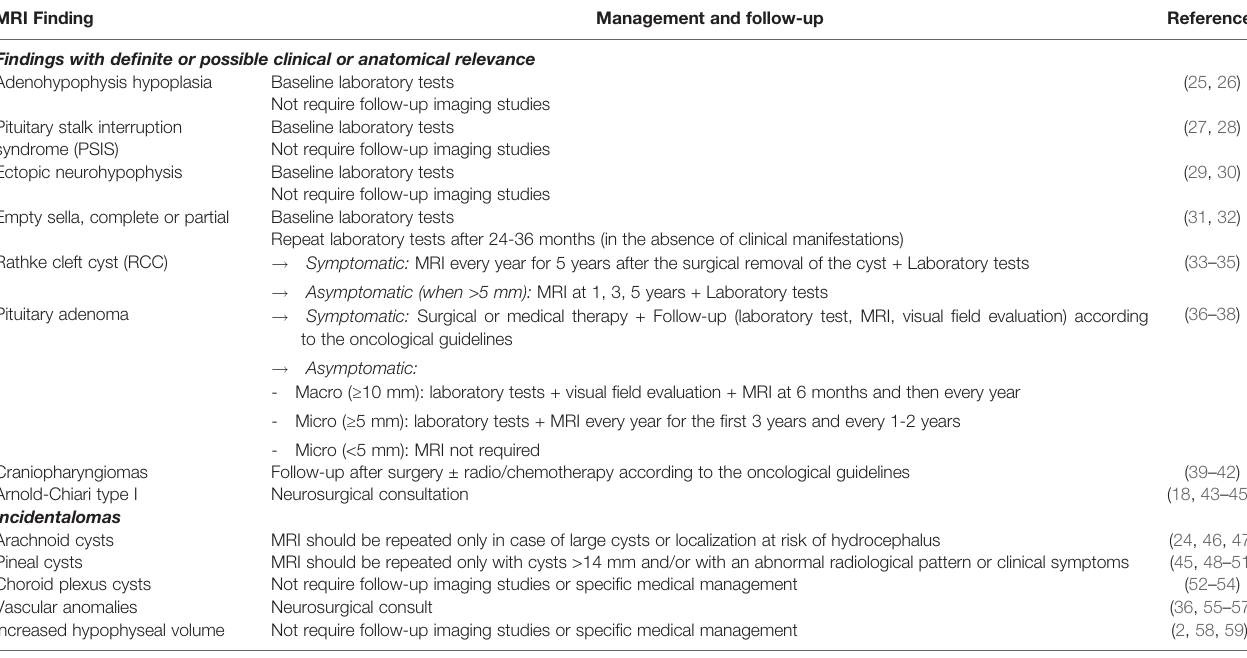
TABLE 1 | Suggested management of the most frequent brain anomalies found in pediatric patients affected by growth hormone de fi ciency (GHD) and central precocious puberty